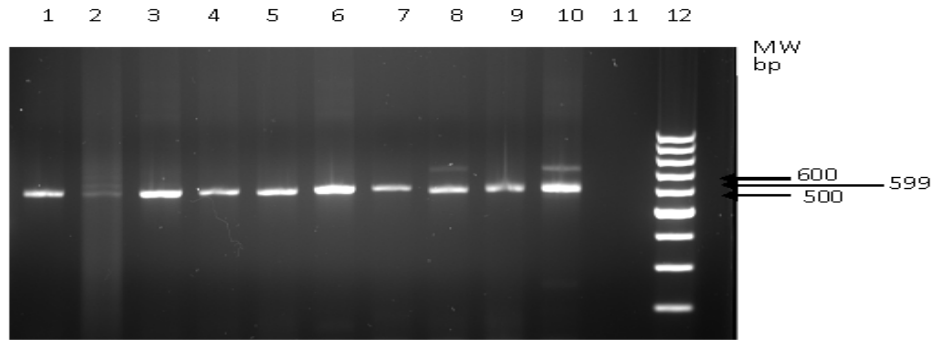
Figure 2. PCR Amplification products SSU rRNA gene from cDNA. Lane 12 = 100 bp ladder; lane 11= negative